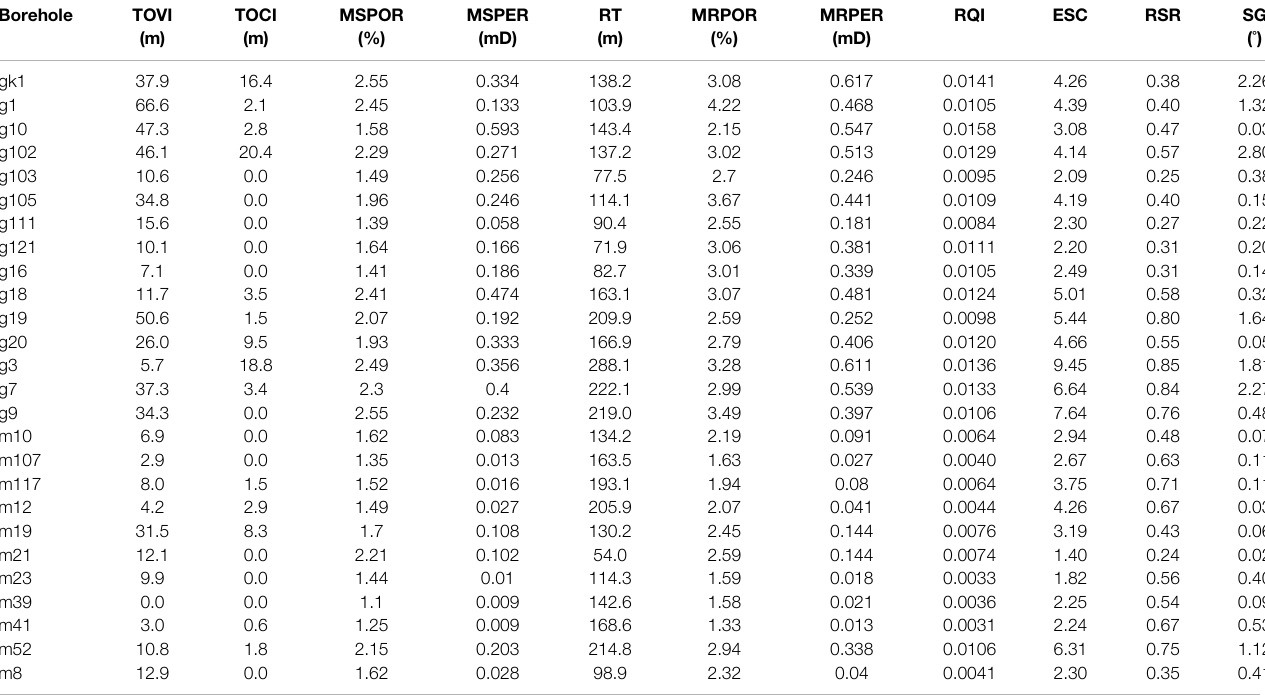
TABLE 2 | Characteristic parameters selected for factor analysis of a part of boreholes. Borehole TOVI (m)